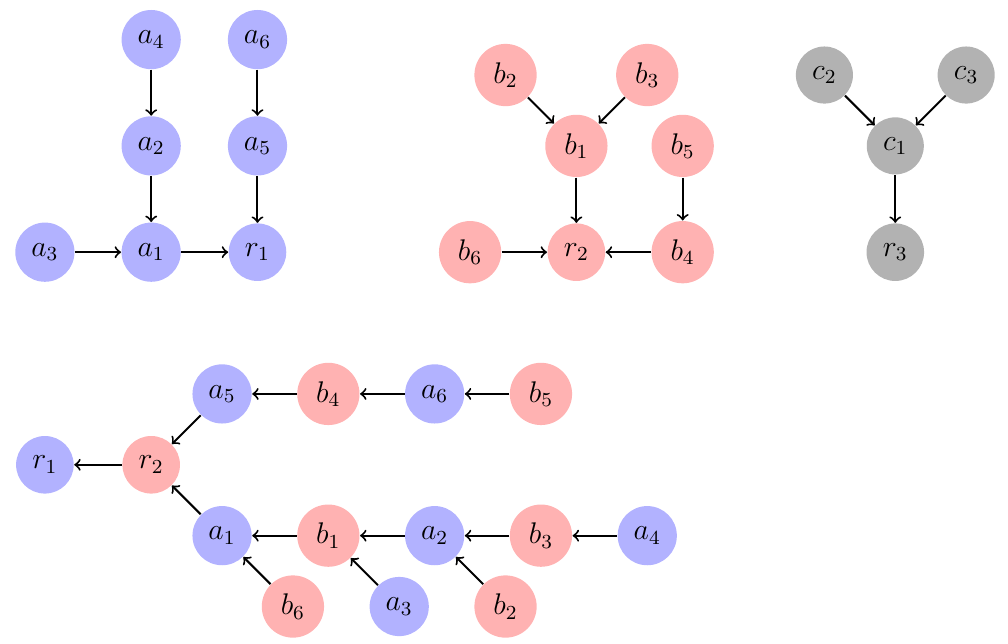
Figure 1: Three in-trees with roots r with root r